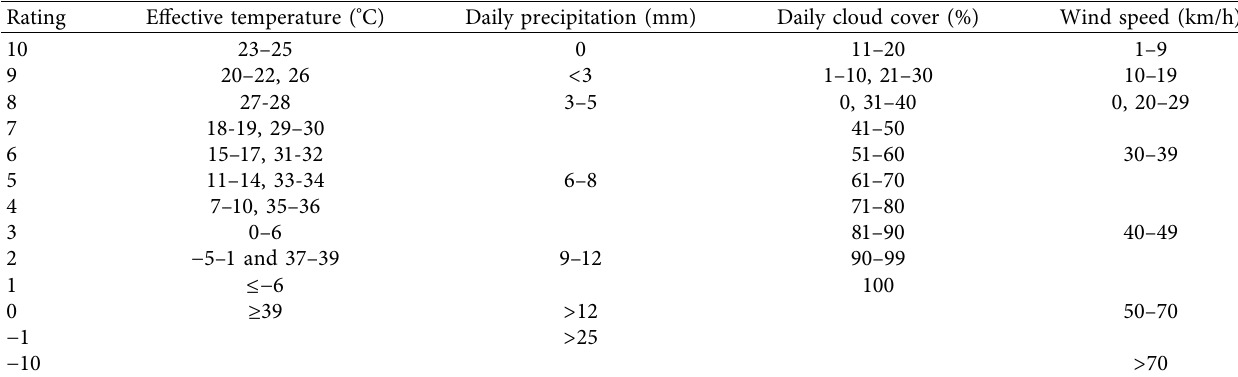
Table 2: Rating scheme of each climate variable.